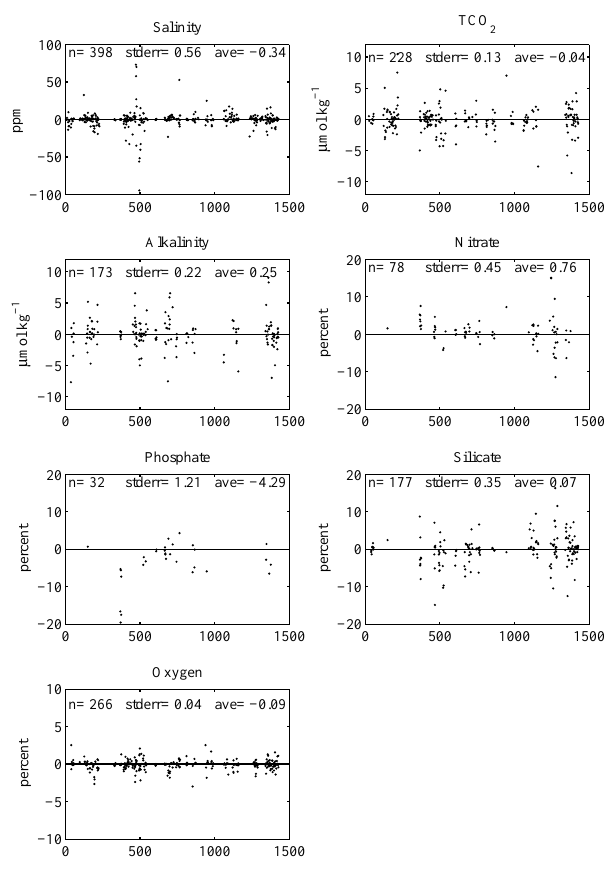
Figure 5. The di ff erence between manually and automatically (with the running-cluster routine) performed crossovers for the CARINA-ATL data set. Numbers shown in the panels are the num- ber of data points ( n ), the standard error (stderr), and the average di ff erence